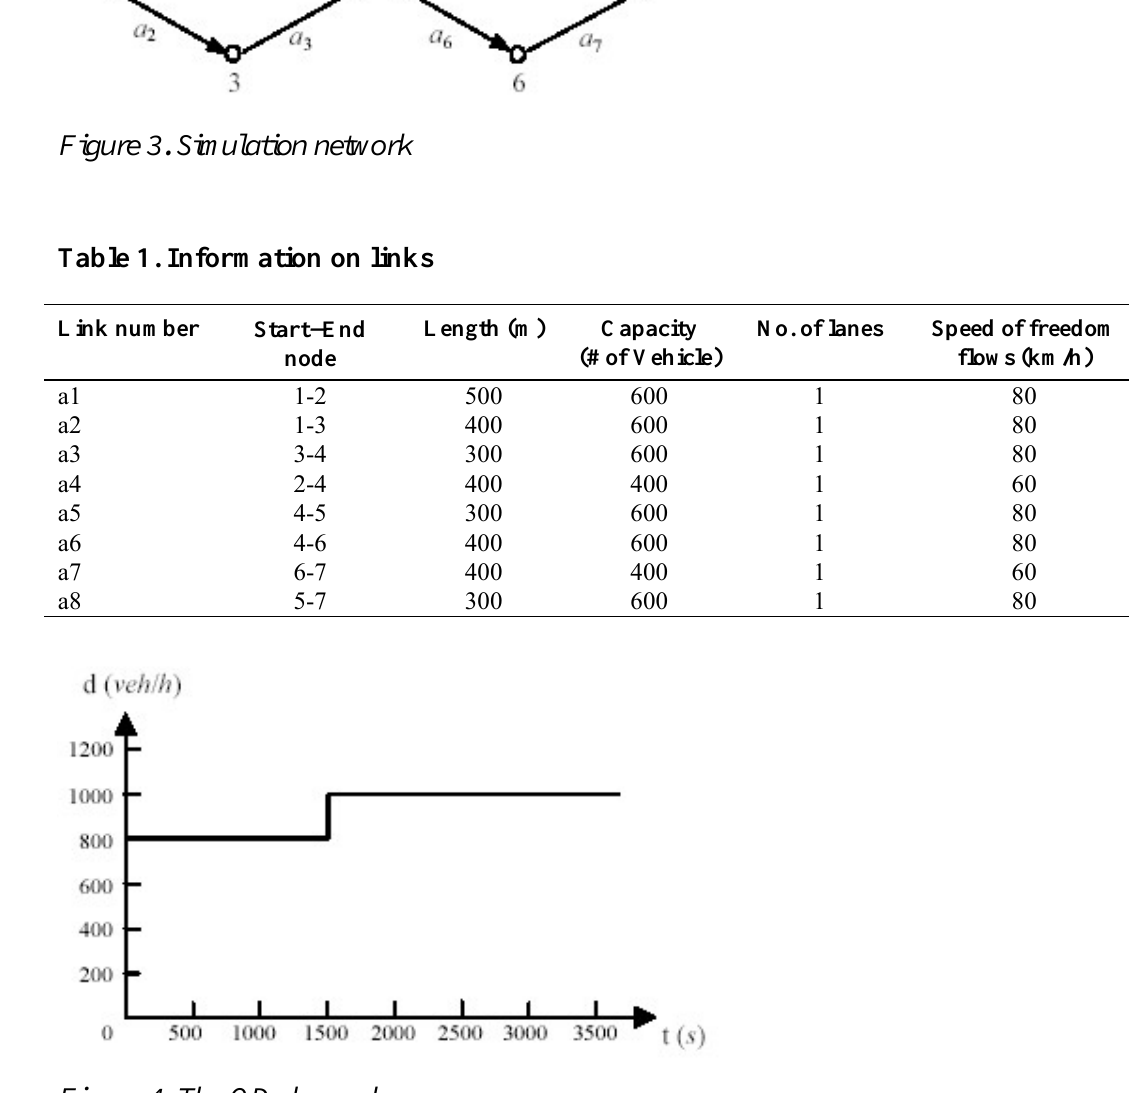
Figure 4. The OD demand